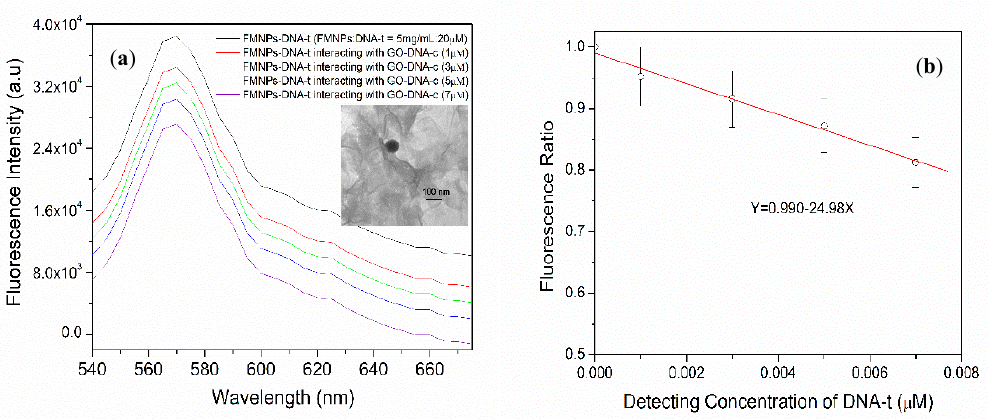
Figure 7. ( a ) The fluorescence quenching performance when the DNA-t modified FMNPs interacting with different concentrations of DNA-c modified GO nanosheet. The small inset is the TEM of the FMNP-DNA-t covalently binding to GO-DNA-c. ( b ) Fluorescence ratio vs. detecting concertation of DNA-t by the solution sensing system.